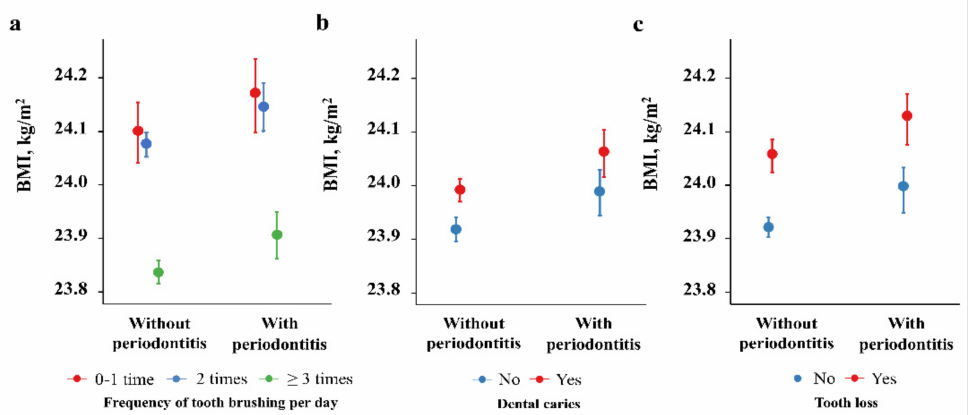
Figure 2. Body mass index according to the presence of periodontitis and oral health indicators: ( a ) BMI of patients according to frequency of tooth brushing, ( b ) BMI of patients according to the presence of dental caries, ( c ) BMI of patients according to the presence of tooth loss. Data are estimated as mean and 95% confidence intervals based on the multivariable linear mixed models for body mass index (fixed effect variables are the same as the models in Table 4). There was no significant interaction effect between periodontitis and other oral health indicators on body mass index ( p value for interaction